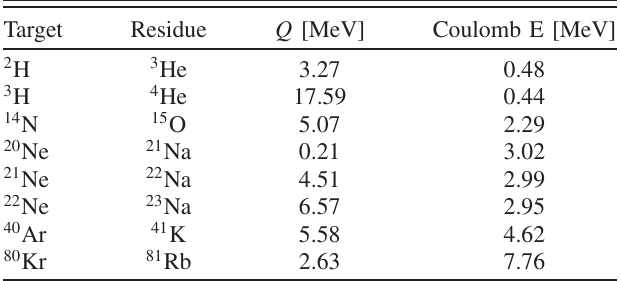
TABLE I. (d,n) reactions on gas targets with positive Q